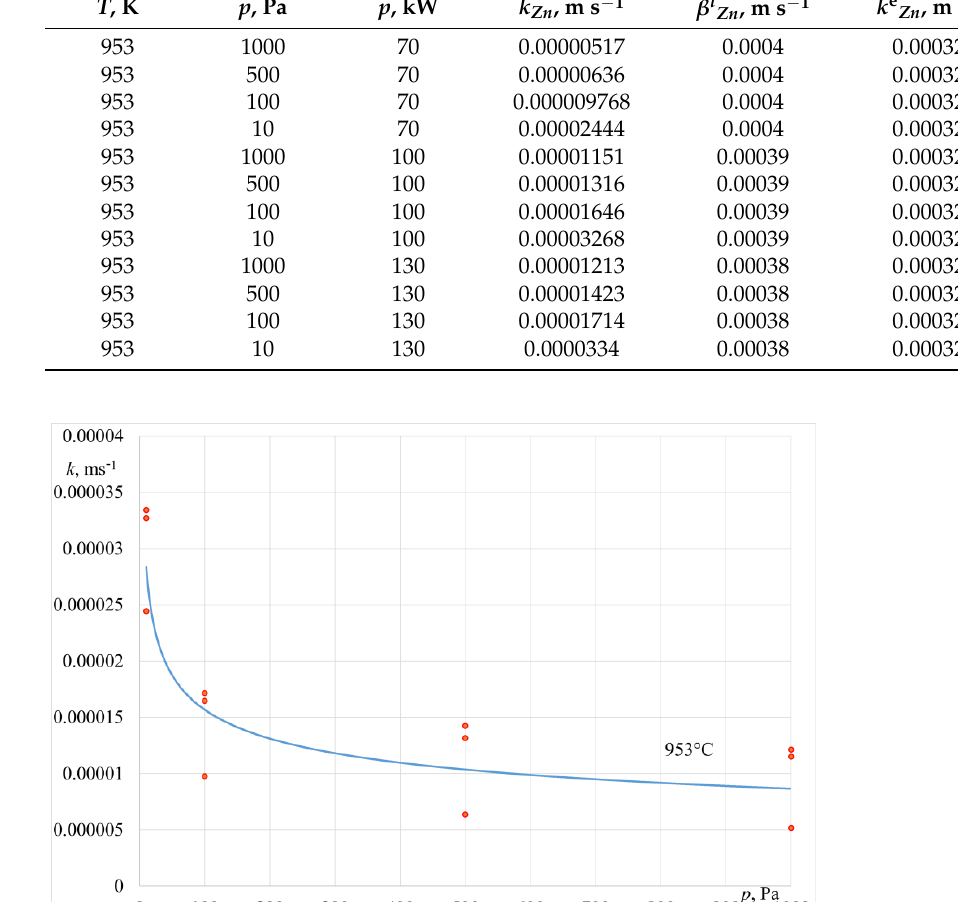
Materials 2021 , 14 , 6641 Figure 8. Variation of overall mass transfer coefficient k Zn vs. pressure (crucible induction furnace). Figure 8. Variation of overall mass transfer coefficient k